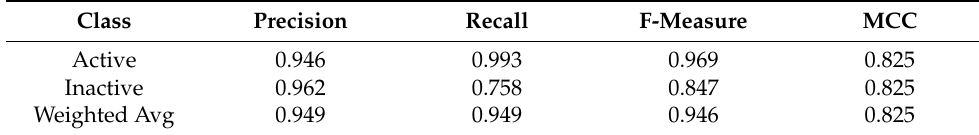
Figure 3. The accuracy of each machine learning algorithm trained using the lazypredict package. ( A ) Balanced Accuracy value of each machine learning classifier; ( B ) Accuracy value of each machine learning classifier; ( C ) F1 score value of each machine learning classifier. Table 1. Prediction values for the training set for the random forest classifier.